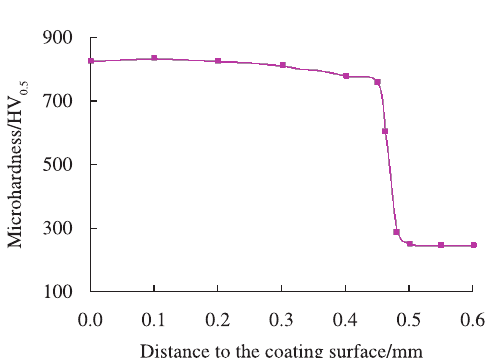
Figure 2c is EDS line scanning results of the coating